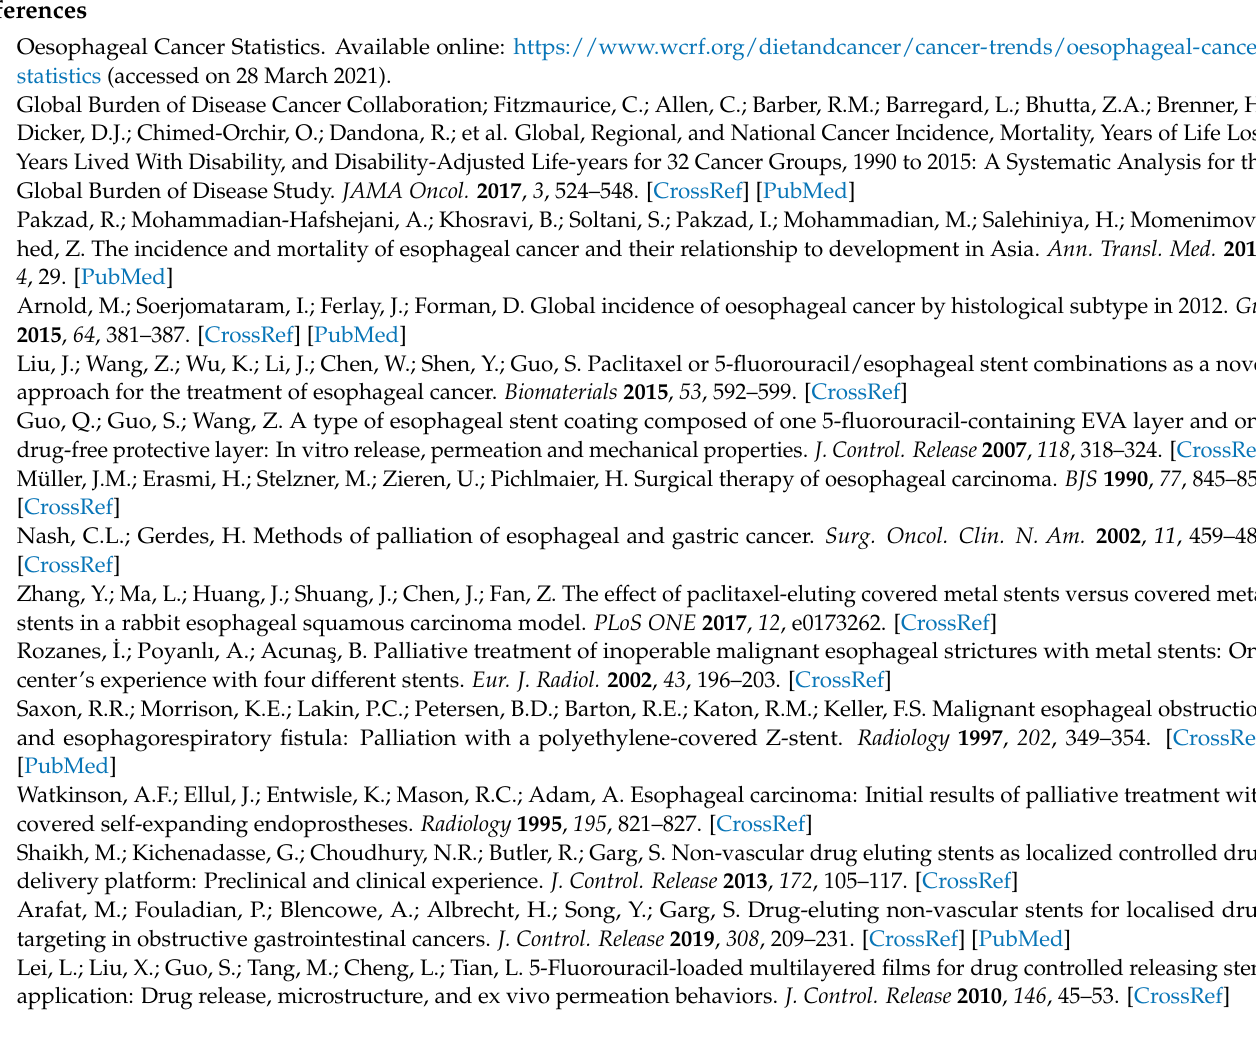
DTX (1 µ g/mL) or DESs solution for 48 h were detected by flow cytometric analysis after Annexin V-FITC/PI double staining. Figure S3: Process of dip coating of metal nitinol oesophageal stent into the DTX-Chronosil solution. Figure S4. (A) Standard calibration curve of docetaxel (in mobile phase medium (mixture of ammonium acetate buffer (0.02 M, 25 mL, pH 5) and acetonitrile